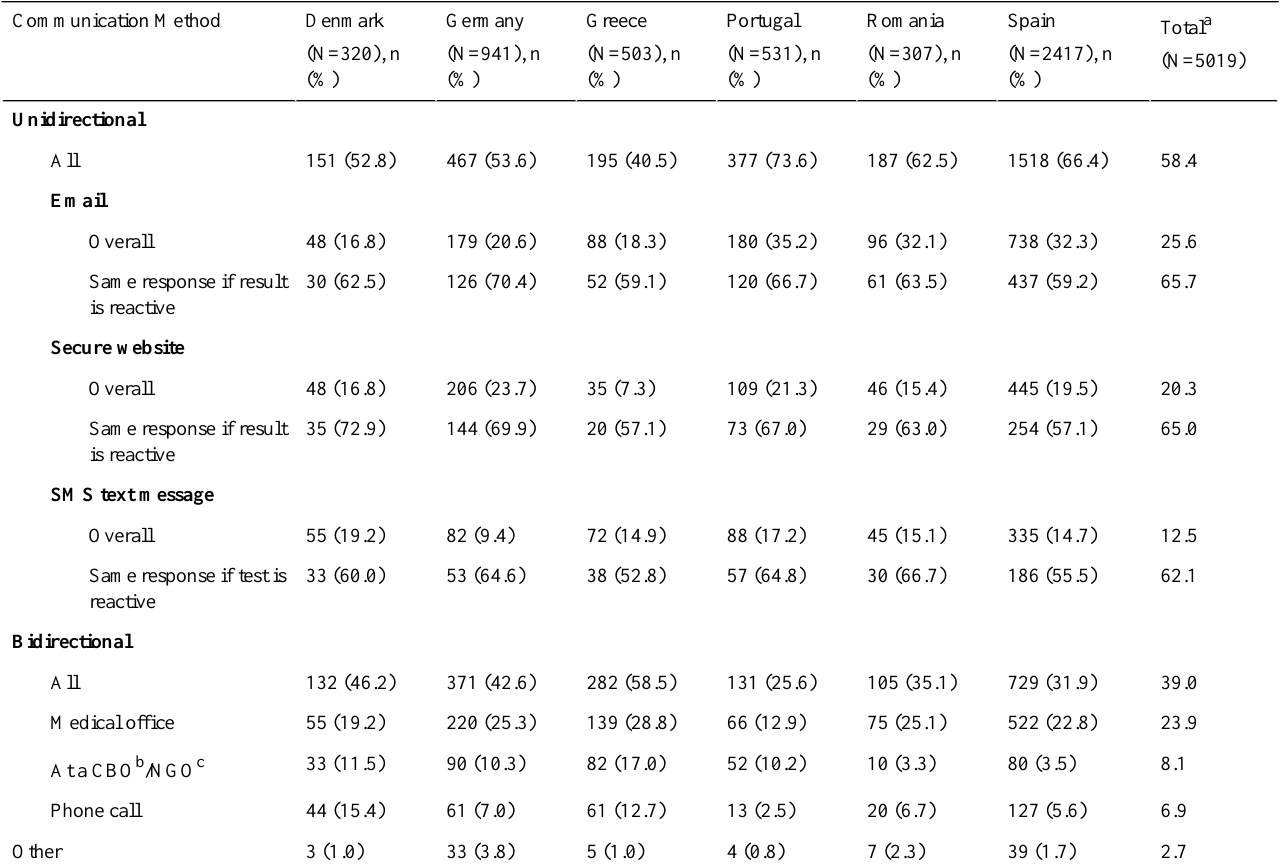
Table 3. Preferred HIV test result communication method in general and for a reactive